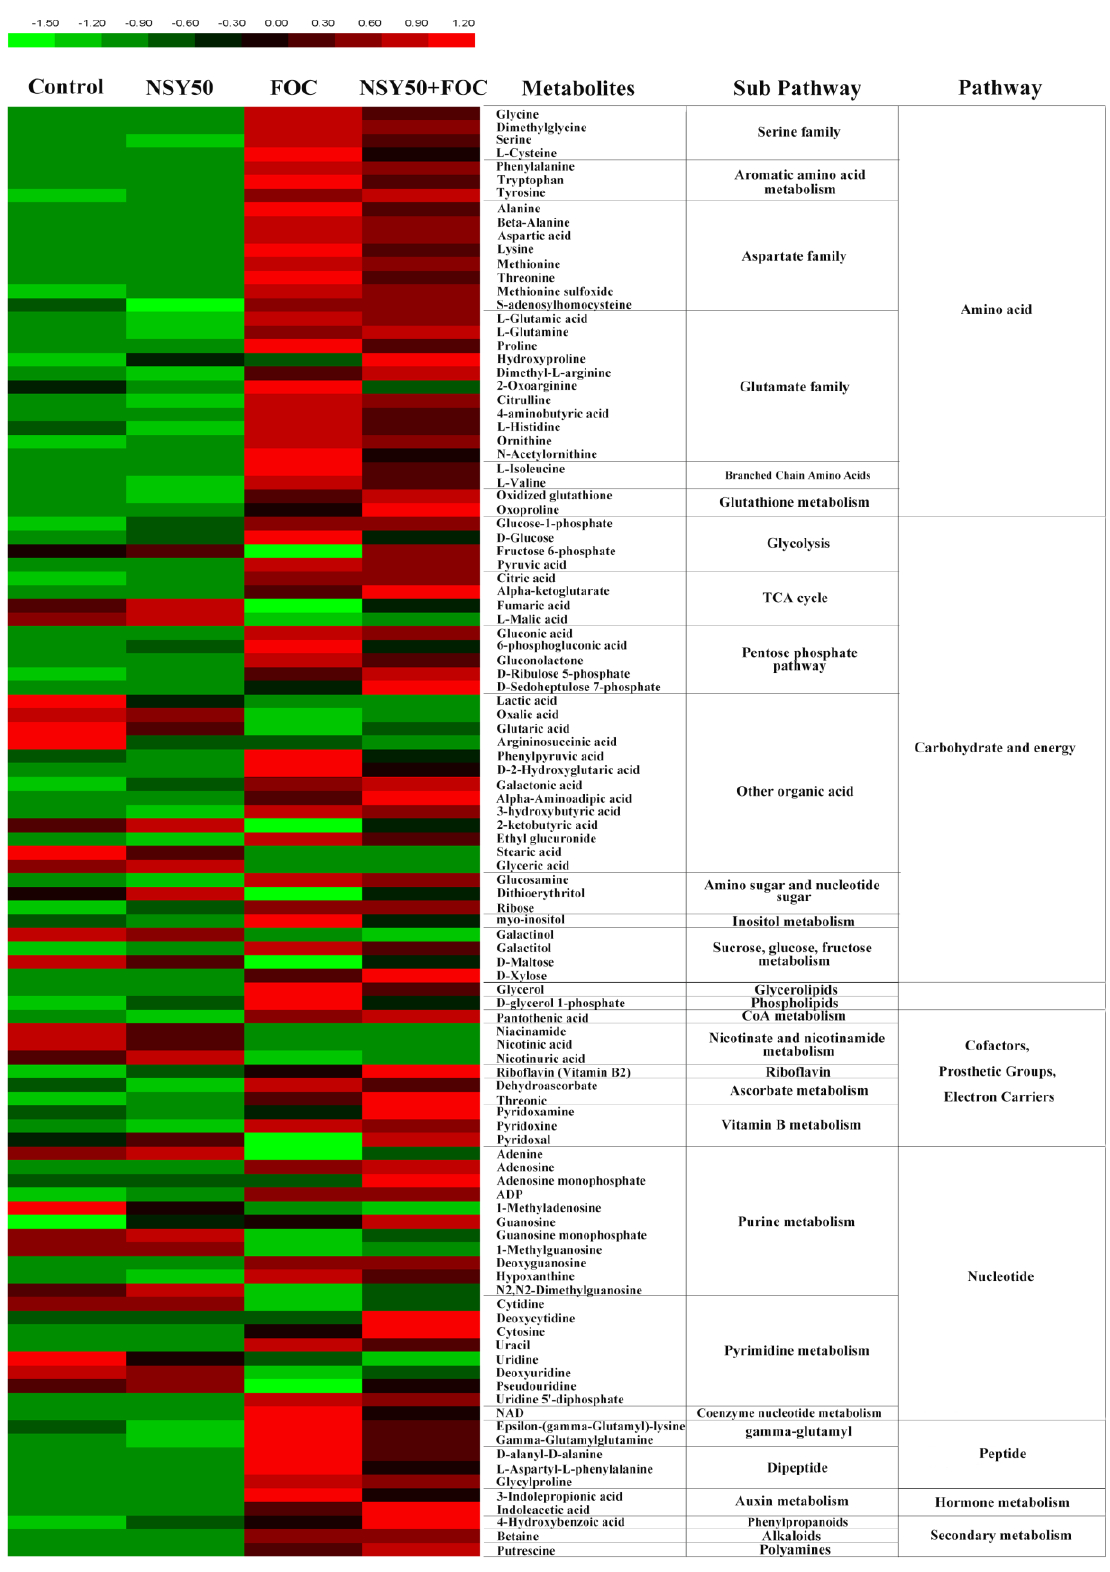
Figure 4. Heatmap of all of the metabolites based on relative peak area in the control and NSY50 and/or FOC-applied cucumber roots. Green (low) to red (high) represents the increase in relative area of each peak among the four treatments. This figure corresponds to Supplemental Table